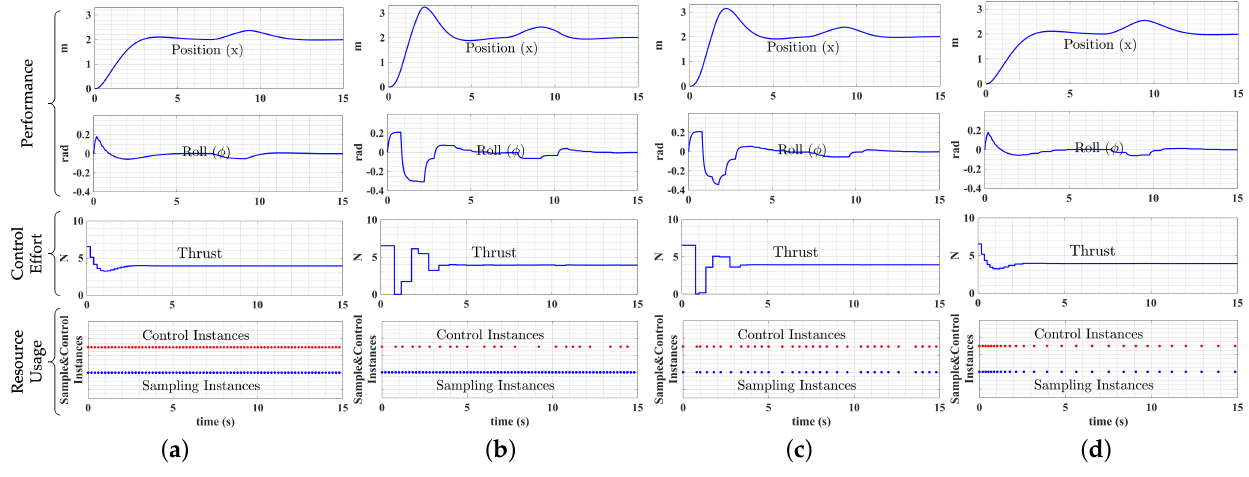
Figure 5. Performance comparison of fixed-periodic, event-triggered, self-triggered control, and co-regulation. ( a ) fixed-periodic DLQR; ( b ) event-triggered control; ( c ) self-triggered control; ( d )